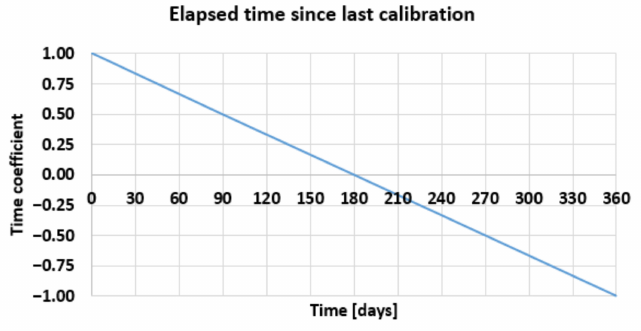
Figure 2. The amount of elapsed time since the last